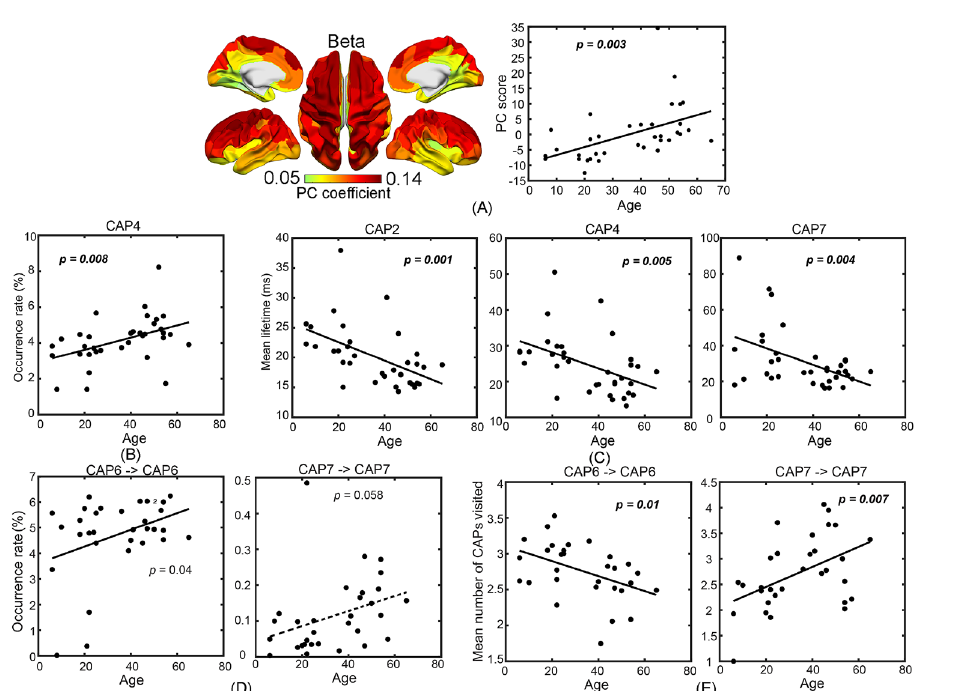
Figure 8. Static and dynamic measures reproduced in female-only data show significant age-related changes (see Supplementary Figs. 2–5 for full results). ( A ) Beta-band PC; ( B ) Occurrence rate of CAP4; ( C ) Mean lifetime of CAPs 2, 4, and 7; ( D ) Occurrence rates of long-range transitions involving two polarized CAPs, i.e., CAP6 → CAP6 and CAP7 → CAP7; ( E ) Numeric counts of other CAPs visited during CAP6 → CAP6 and CAP7 → CAP7. The lines denote the linear regression models (dashed line indicates a p value close to 0.05), whose p values are listed in the panels (bold italic font: survived with either FDR or Bonferroni